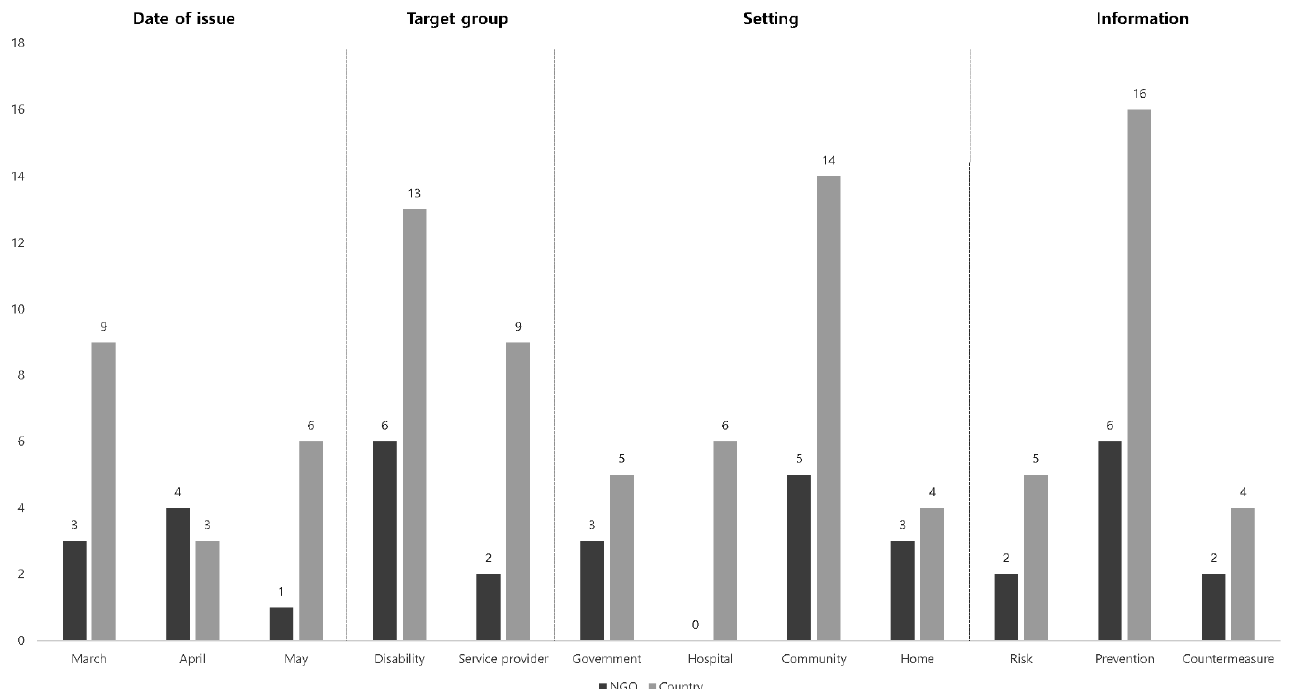
Figure 3. Guidelines published by NGO and country.